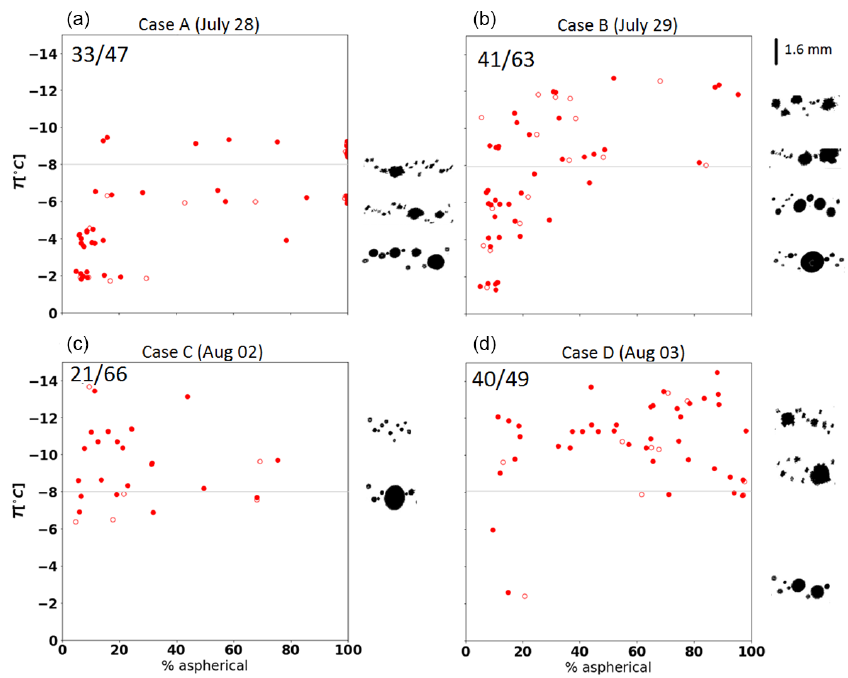
Figure 4. The percent of hydrometeors (in red) that were classified as non-spherical at the corresponding temperature for updraft cores (open circles) and penetrations not meeting updraft core criteria (dots) for the 4 days in the study. Only particles with D > 300m were considered. The fractional number represents the number of penetrations that contained at least 10 such particles. Example images from the OAP CIP of hydrometeors observed during penetrations at the indicated temperature are shown on the right side of the graph for each day. A scale for the images is shown in panel (a)